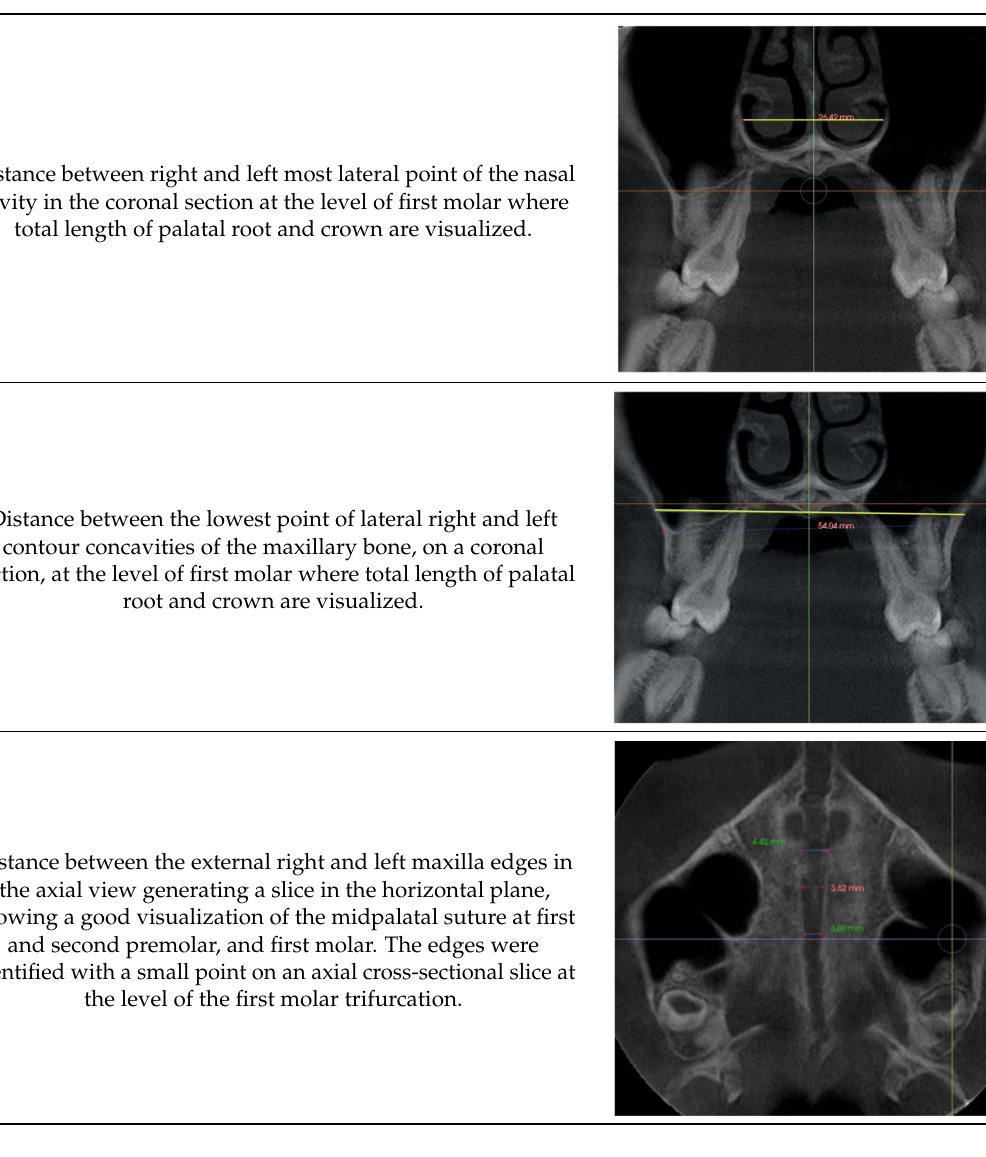
Table 2. Description of radiographic CBCT measurements performed with In vivo software program. Standardized coronal and axial sections for radiographic measurements of first and second premolars, and first